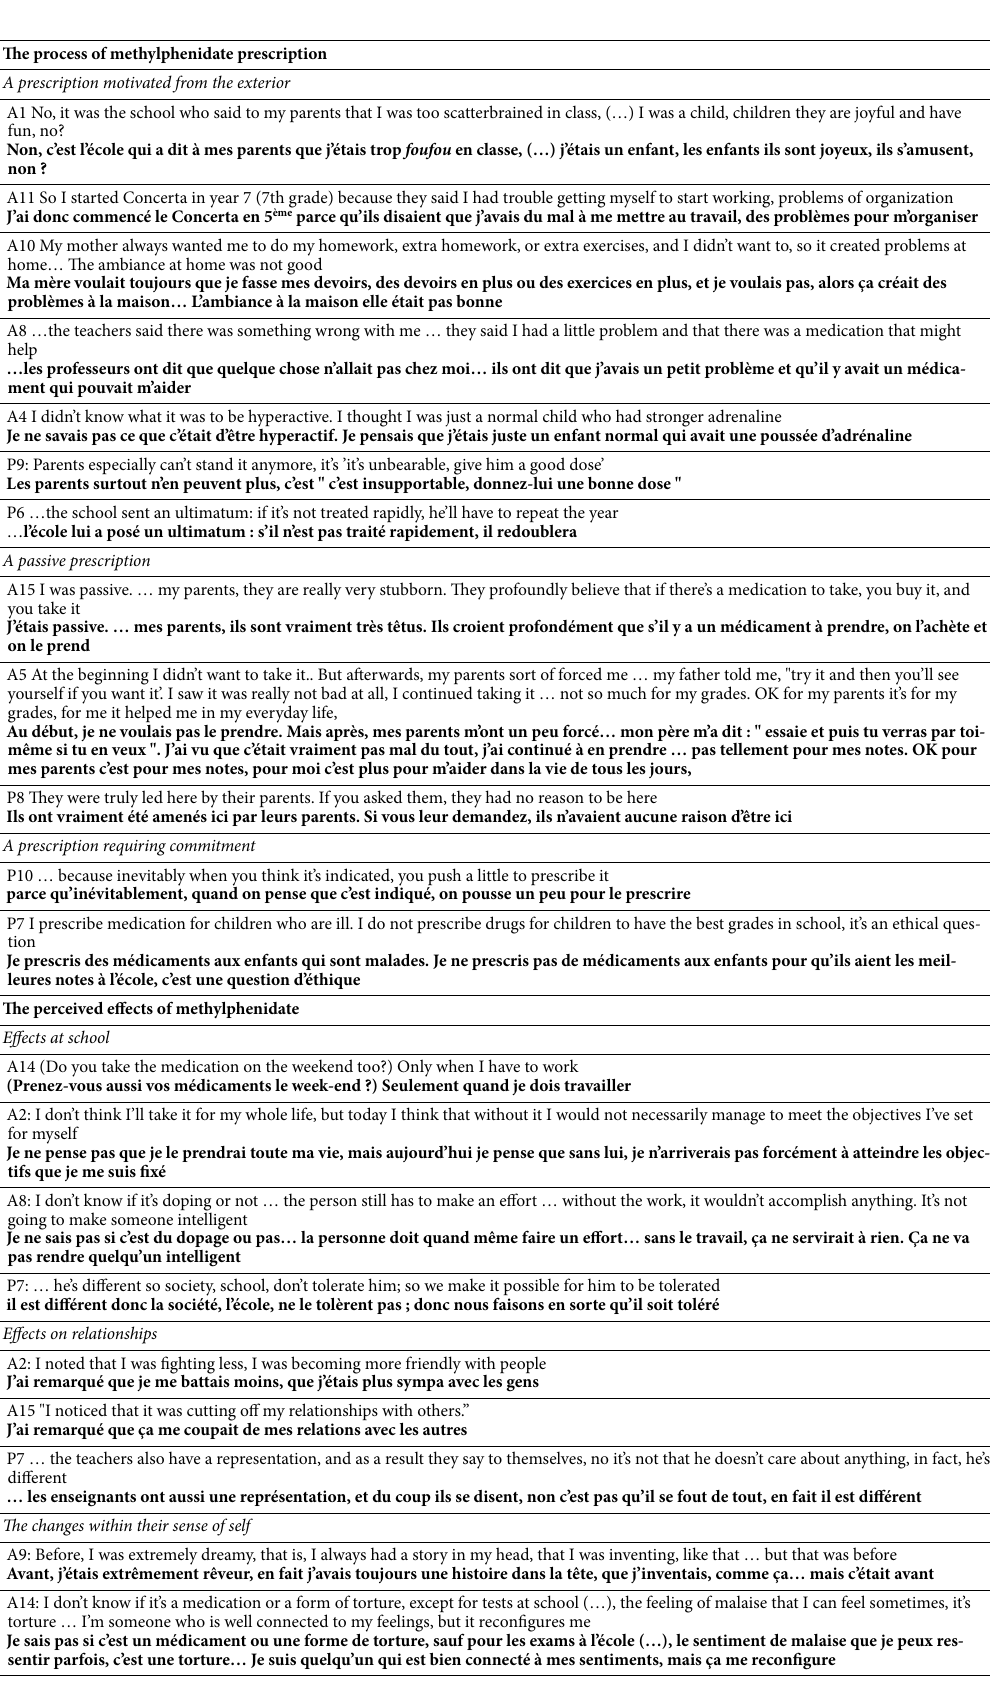
Table 5. Original French